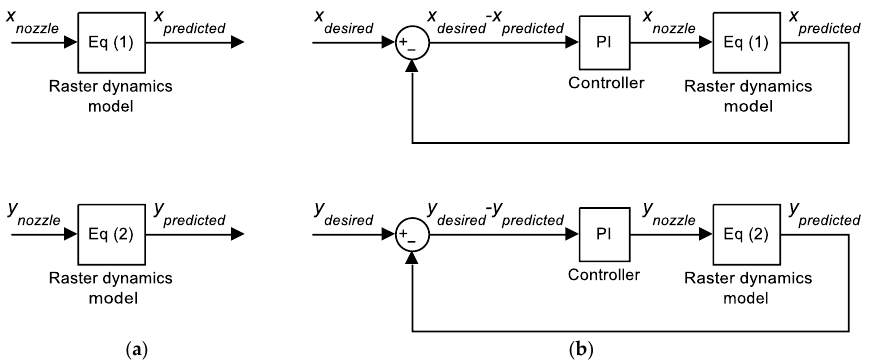
Figure 6. Schematic of the raster dynamics simulation ( a ) without and ( b ) with proportional and integral (PI) compensation.